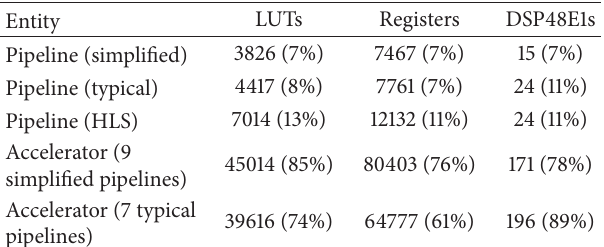
Table 2: Zynq-7020 resource utilization.